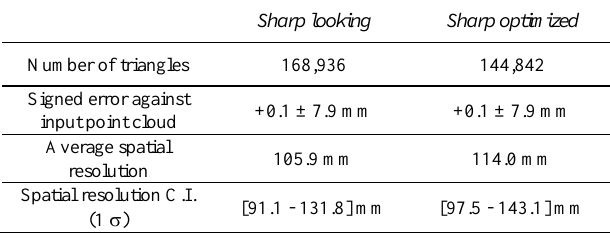
Table 4. Result of the sharp simplification method.